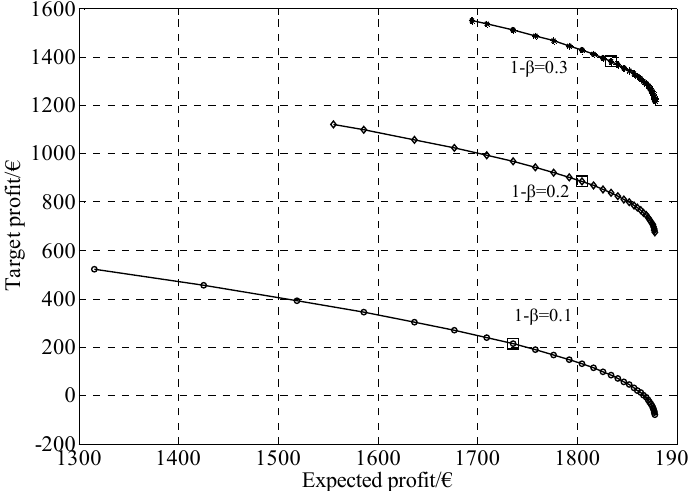
Figure 8. Pareto optimal front versus different 1 − β under the ECPS.